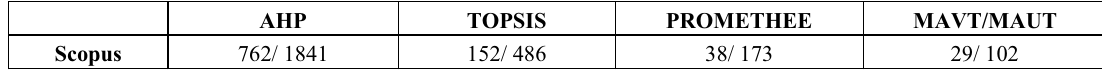
Table 4. Usage of MCDA methods. Number of articles in Scopus database for 2000-2014 in which MCDA method was mentioned: Numerator - the method and words associated with risk management are mentioned in TAK (Tittle-Abstract-Keywords); Denominator - words associated with risk management are mentioned in TAK and the method is mentioned in the full text of an article. AHP TOPSIS PROMETHEE MAVT/MAUT Scopus 762/ 1841 152/ 486 38/ 173 29/